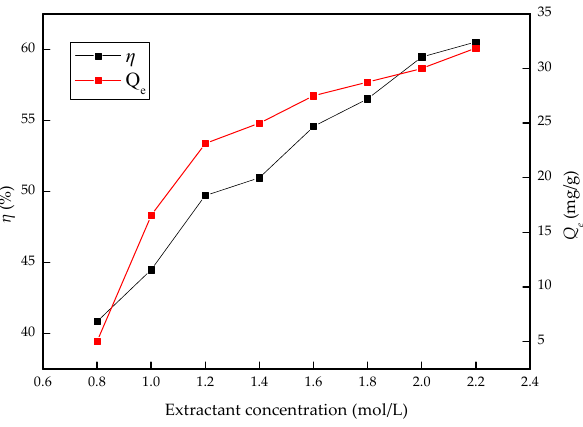
Figure 3. Effects of extractant concentration on the adsorption capacity and impregnation ratio of resins (D2EHPA:TBP = 7:3, adsorption time 16 h, pH 1.8). resins (D2EHPA:TBP = 7:3, adsorption time 16 h, pH 1.8). resins (D2EHPA:TBP = 7:3, adsorption time 16 h, pH 1.8).